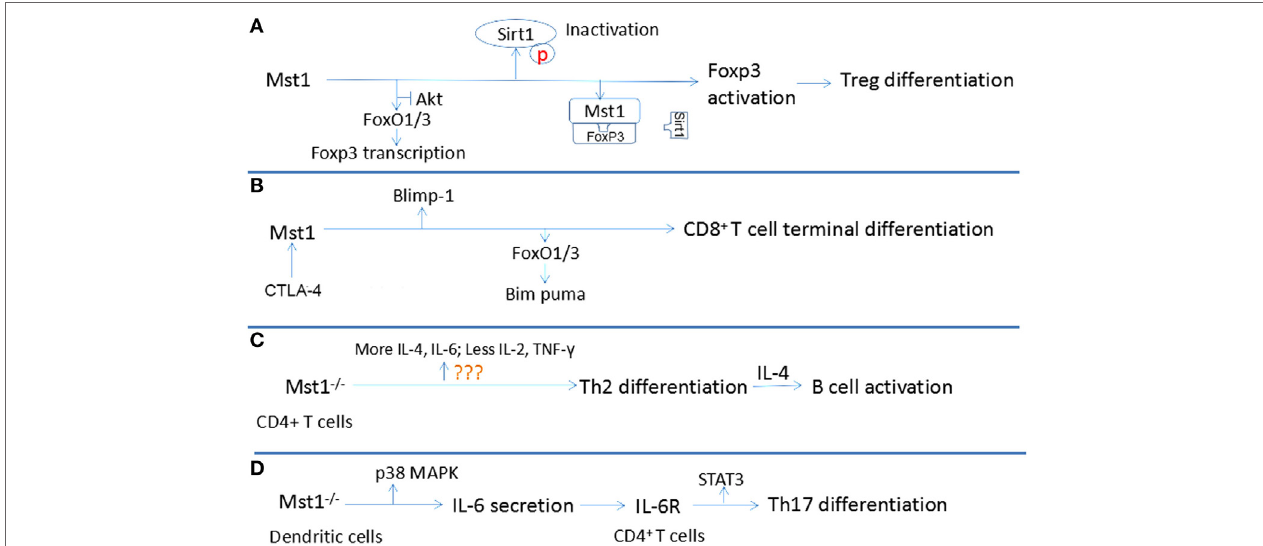
FiGURe 3 | Relationship between Mst1 and T cell differentiation. (A) Mst1 promotes the activation of Foxp3 through antagonizing the activity of AKT and Sirt1, inducing the differentiation of regulatory T cell (Treg). (B) Combination of CD80 to CTLA-4 activates Mst1, which regulates the activity of Blimp1 and Bim puma, facilitating the terminal differentiation of CD8 + T cells. (C) Mst1 − / − CD4 + T cells are inclined to differentiate to T helper cells (Th)2, which induce B cell activation by producing interleukin (IL)-4. (D) Mst1 − / − dendritic cells secret more IL-6, which regulates Th17 differentiation by agonizing IL-6R of CD4 + T